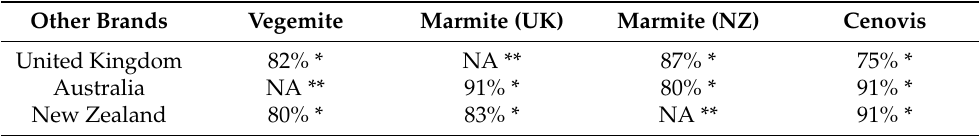
Table 7. Ability to correctly identify the “odd one out” in an impromptu sensory triangle test. Other Brands Vegemite Marmite